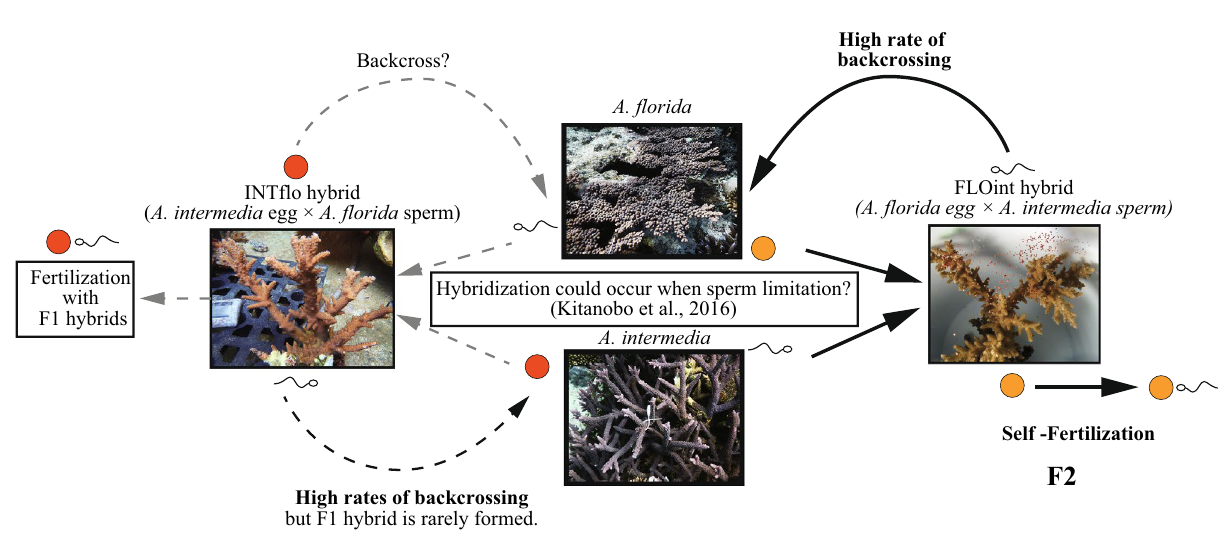
Figure 3. Schema of F1 hybrid reproduction. Flow from A. intermedia and A. florida , F1 hybrids, to reproduction of F1 hybrids. According to our studies, hybridization can occur when the sperm concentration is low, and an F1 hybrid (FLOint) can backcross or reproduce asexually. Bold lines indicate probable pathways, which are supported by this and our previous studies; faint grey lines indicate pathways that may not occur because of the low probability of